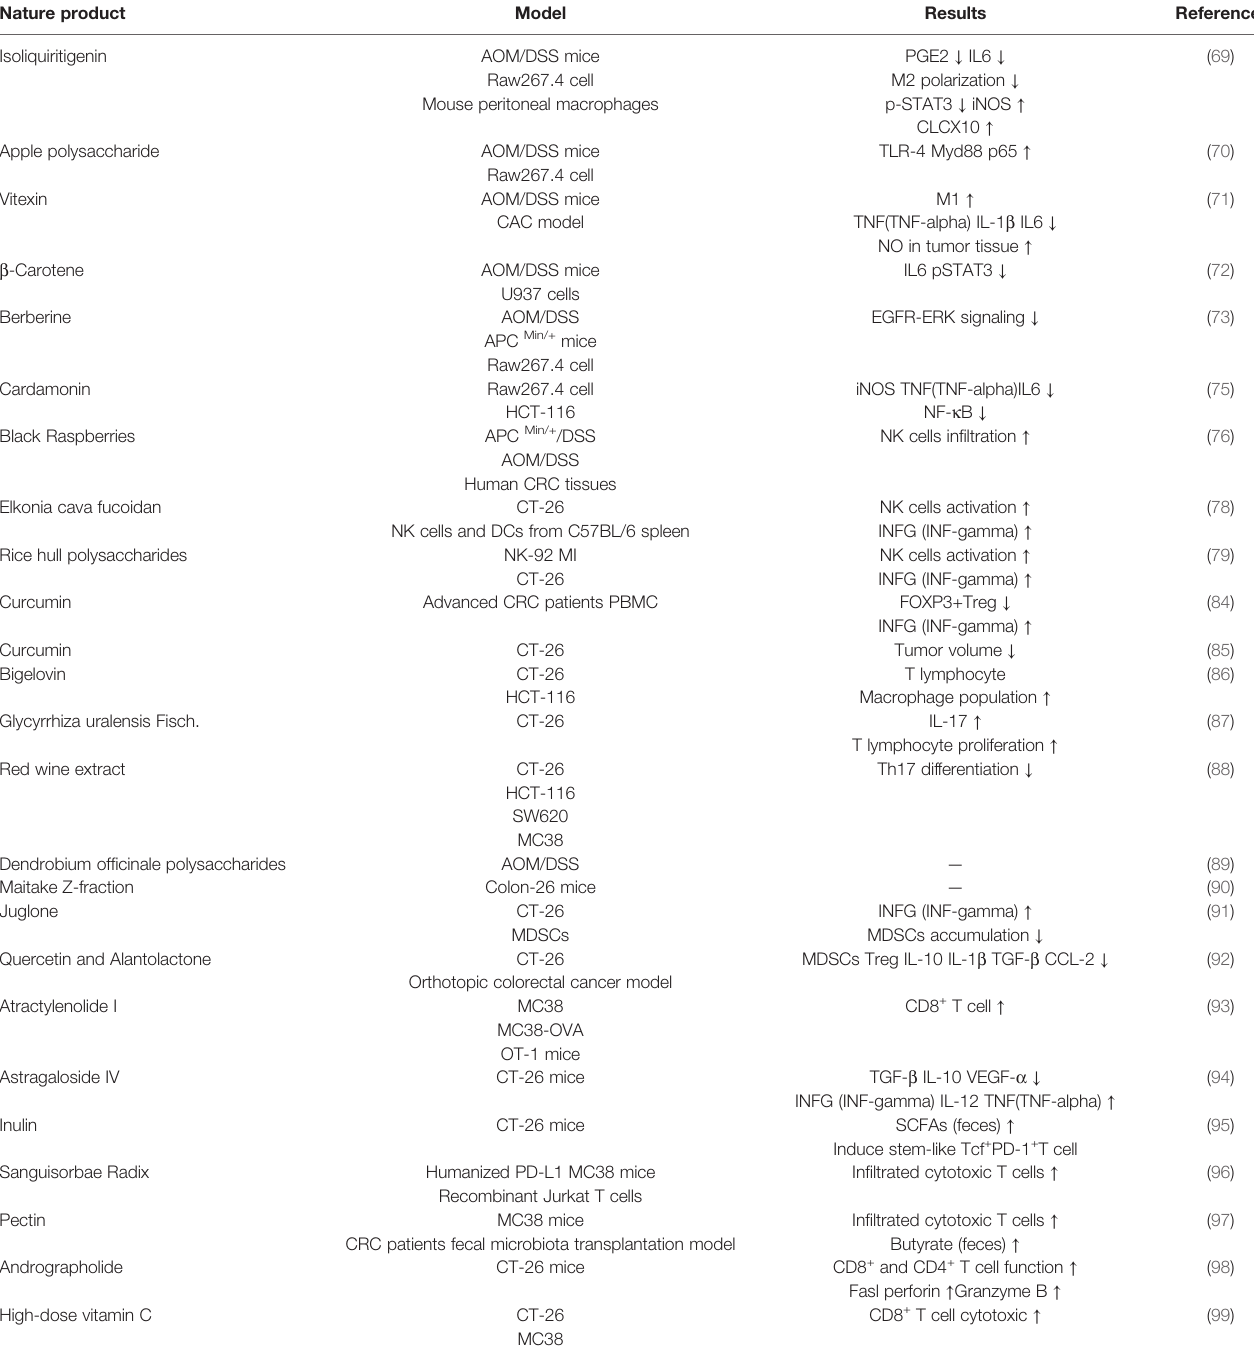
TABLE 1 | Natural products exert modulating effects on the immune system in